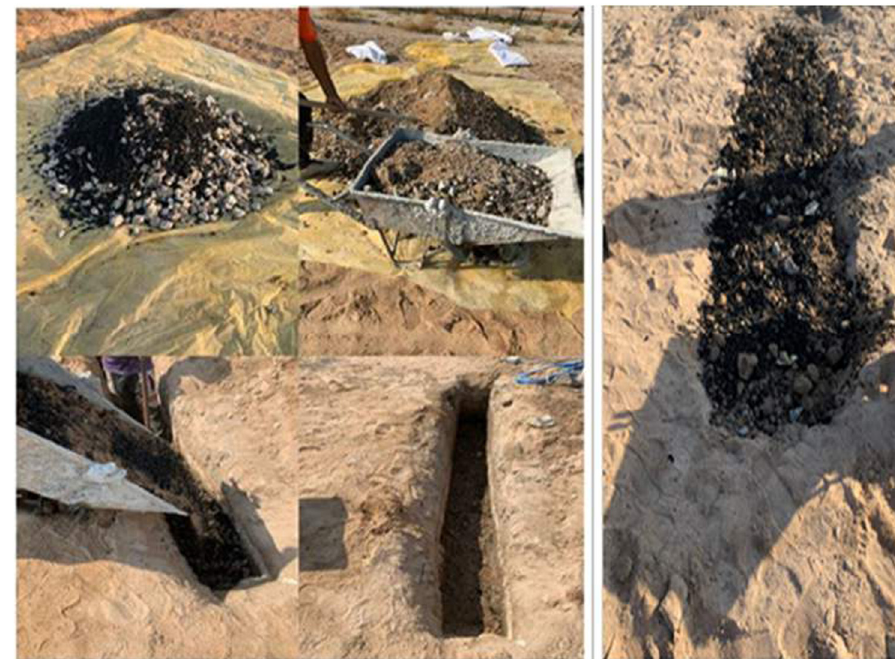
Figure 13: Trench fi lling